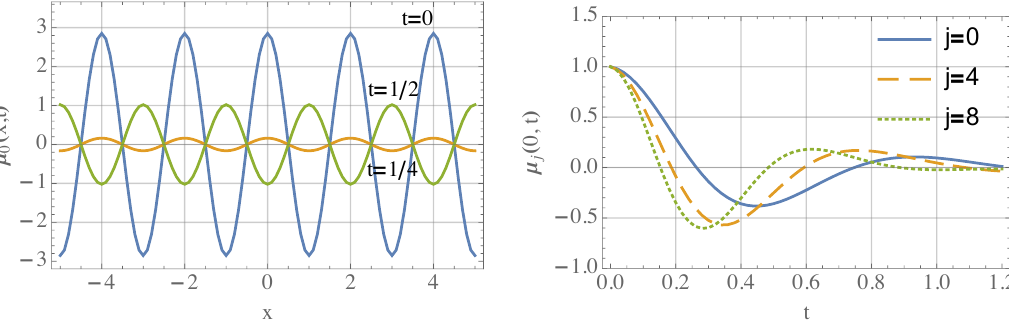
Figure 5: Left panel: the initial profile n ( θ )( 1 − n ( θ )) . Right panel: the evolution of ( t ) with and without the diffusion. mode occupation δ n k = 1